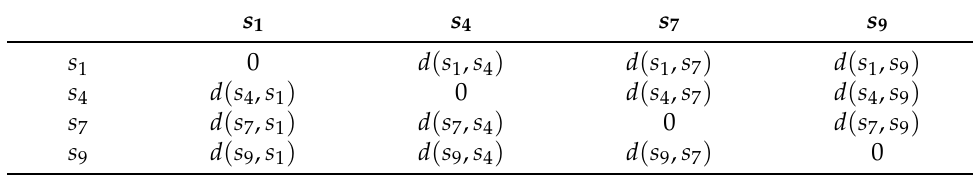
Table 1. Example of the undirected